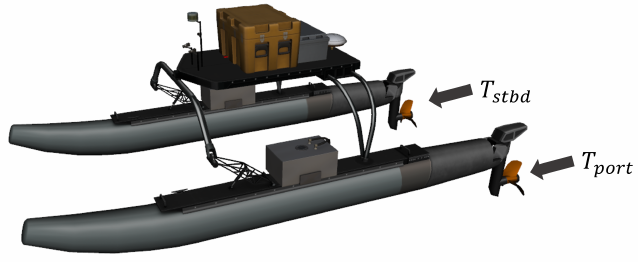
Figure 8. Appearance of WAM-V. Table 1. Specifications of